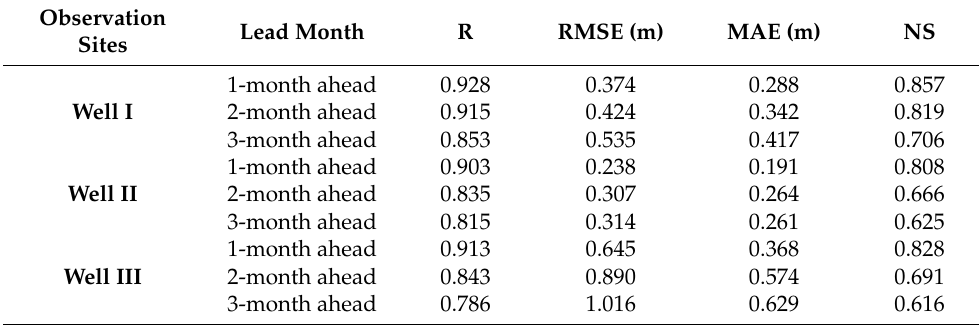
Table 5. Performance analysis of the ELM models during testing periods for three